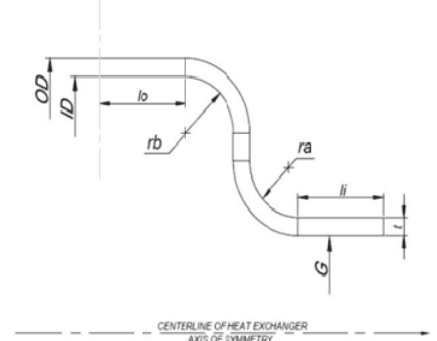
Figure 6: Two-dimensional model of wall expansion